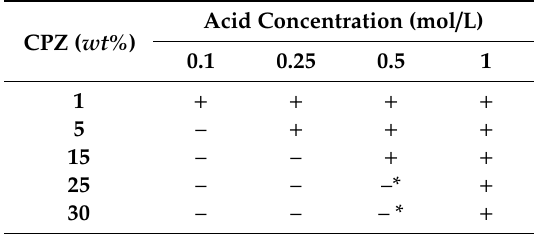
Table 1. Hexa(allylamino)cyclotriphosphazene (CPZ) solubility in aqueous H 3 PO 4 , H 2 SO 4 , and HCl solutions.